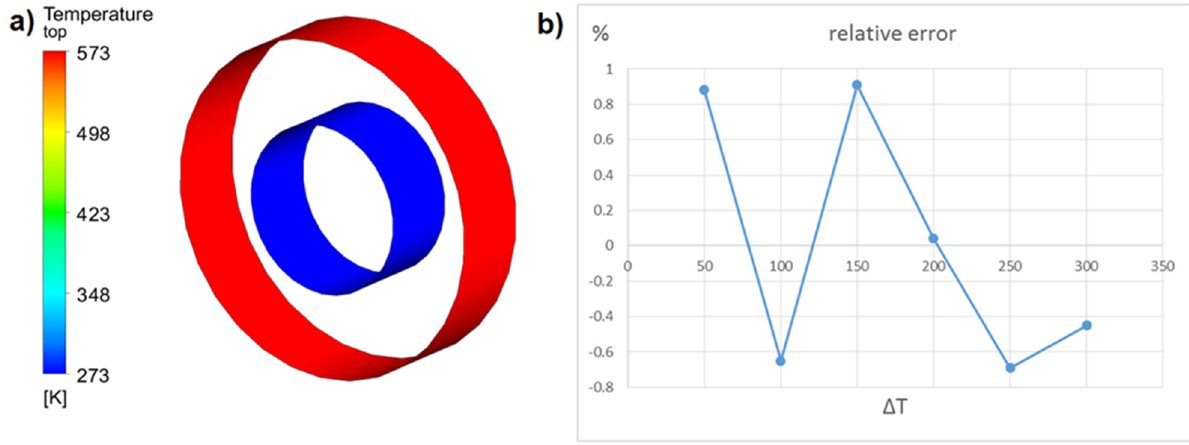
Figure 4. ( a ) View of the tested geometry, 1-insert, 2-pipe; ( b ) relative error of radiation fluxes.